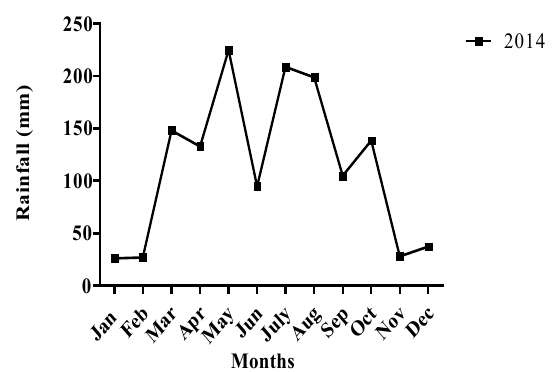
Figure 1: Monthly Rainfall Pattern for the Study Area 2014 Source: OAU Teaching and Research Farm Meteorological Station